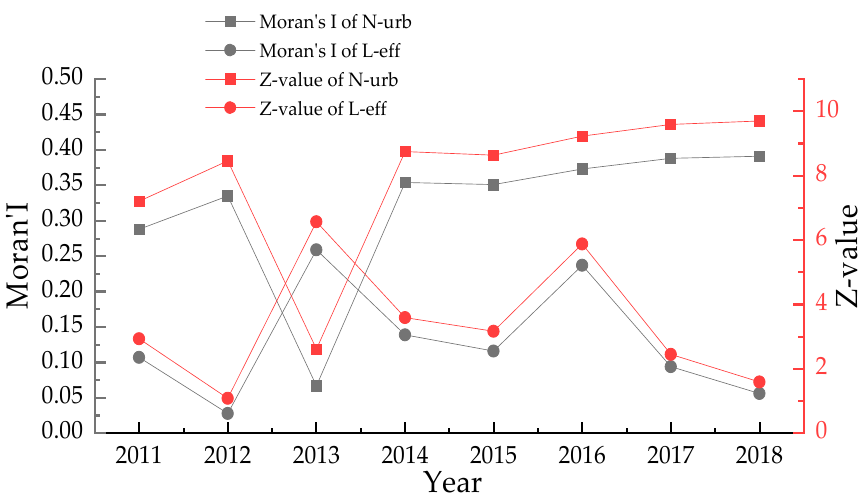
Figure 5. Global Moran’s I and Z-value evolution characteristics of new-urbanization level and green land utilization efficiency in China.